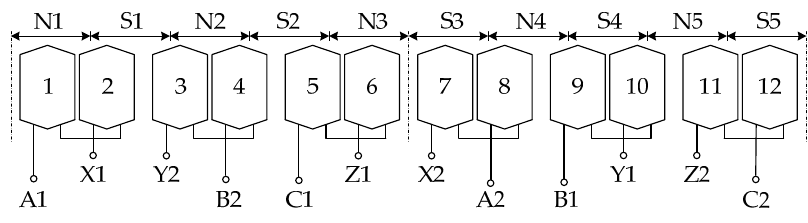
Figure 2. Stator windings outspread diagram of the DRPMSM.